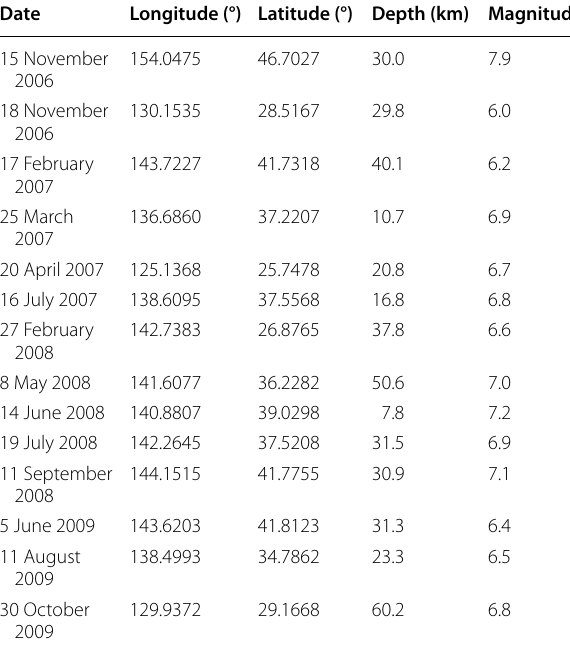
Table 1 List of large earthquakes whose coordinate offsets are removed from GNSS data